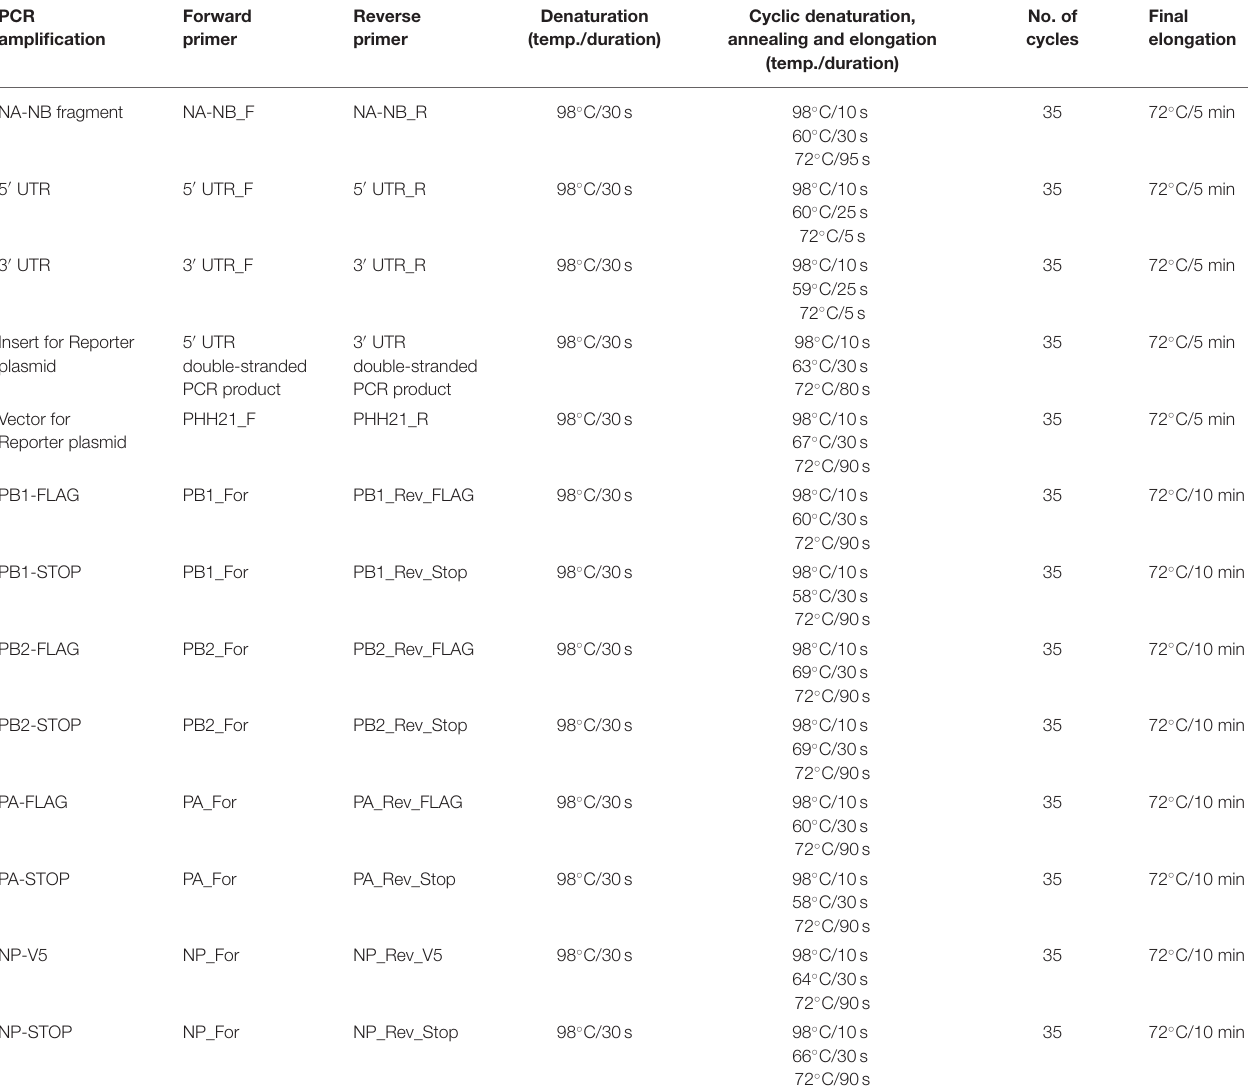
TABLE 2 | PCR conditions used in the study for amplification of individual inserts. PCR amplification